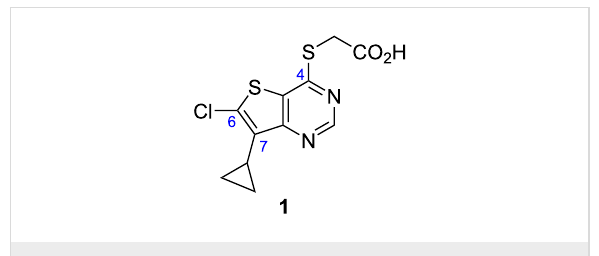
Figure 1: Chemical structure of Notum inhibitor LP-922056 ( 1